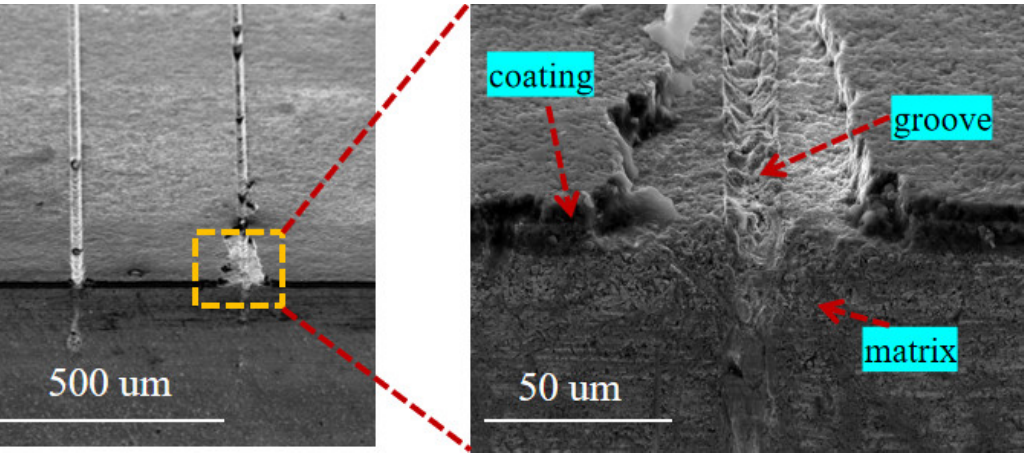
Figure 6. The SEM of the cross-sectional image of the groove structure was processed (the laser pulse energy is 25 μJ, the scanning speed is 2 mm/s, and scanning times is 1).